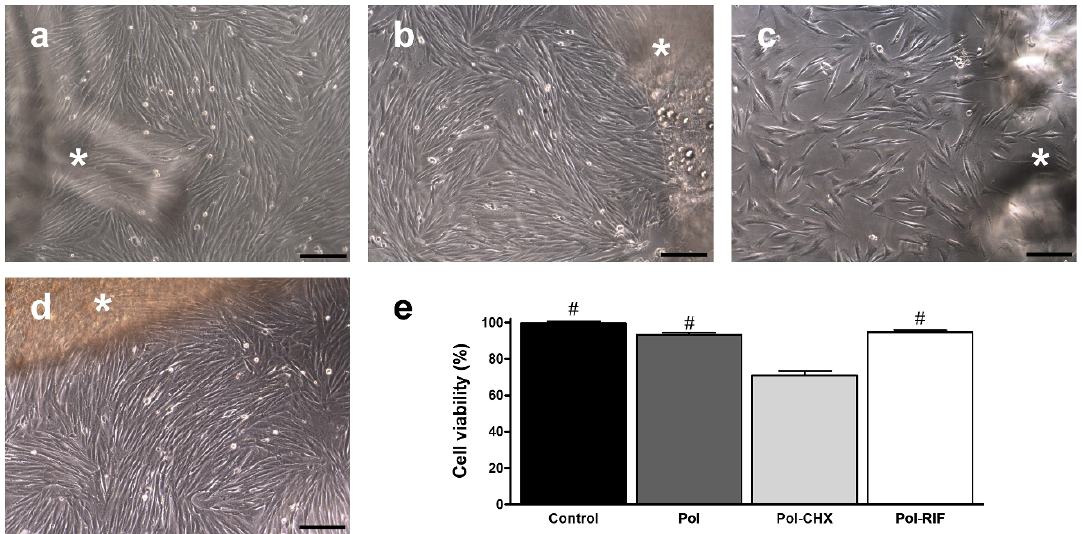
Figure 4. Light-microscopy micrographs (scales: 100 µm) of rabbit skin fibroblast cultured in the presence of a ( a ) control, ( b ) Pol, ( c ) Pol-CHX, or ( d ) Pol-RIF material. In each picture, the corresponding mesh is depicted (asterisks). The cells influenced by Pol-CHX coated meshes ( c ) exhibited slight morphological changes. ( e ) Analysis of cell viability after a 24-h exposure to the different materials ( n = 9 each). Viability of fibroblasts decreased when cultured with Pol-CHX, compared to the rest of the study groups (#: *** p < 0.001).